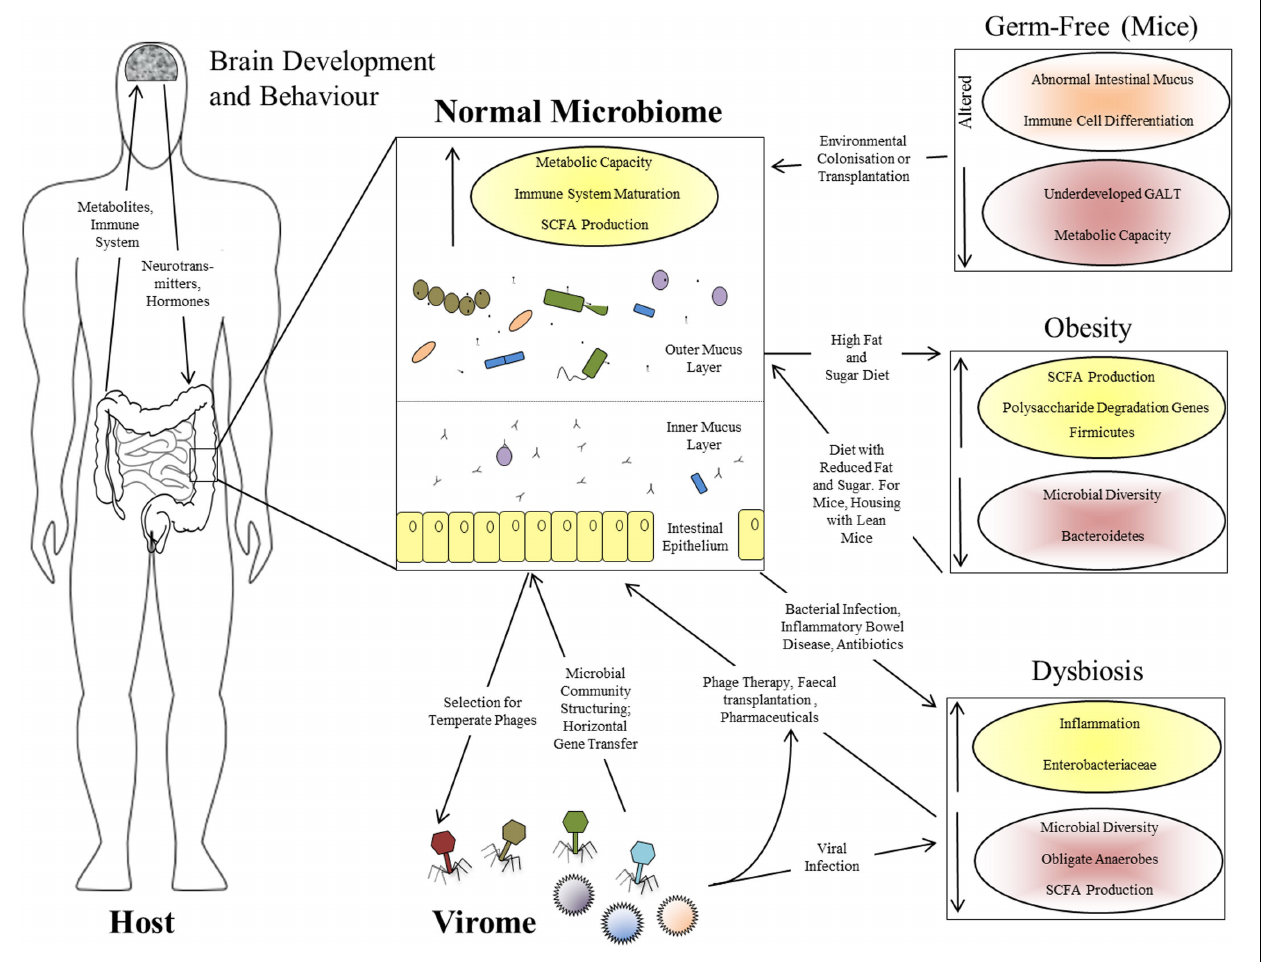
FIGURE 1 | Interactions between the human host, the intestinal microbiome, and the virome. Functional effects of a normal intestinal microbiome are illustrated, together with the bi-directional interactions between the microbiome and virome, and between the GI tract and brain via the microbiome. The panels at the right show the perturbations associated